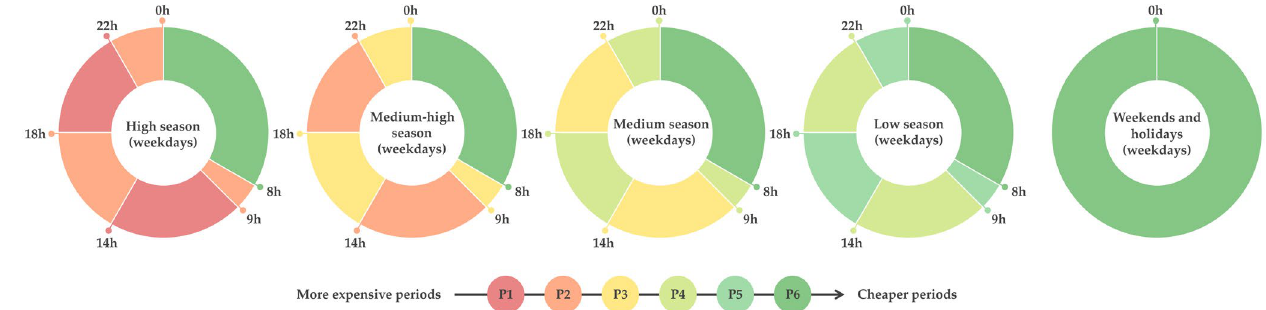
Figure 2. Energy and power periods for the 3.0 TD tariff. The price of electricity is discriminated according to electrical seasons (high, medium–high, medium and low), the day of the week and the time of day. (High season: January, February, July and December; medium–high season: March and November; medium season: June, August and September; and low season: April, May and October).